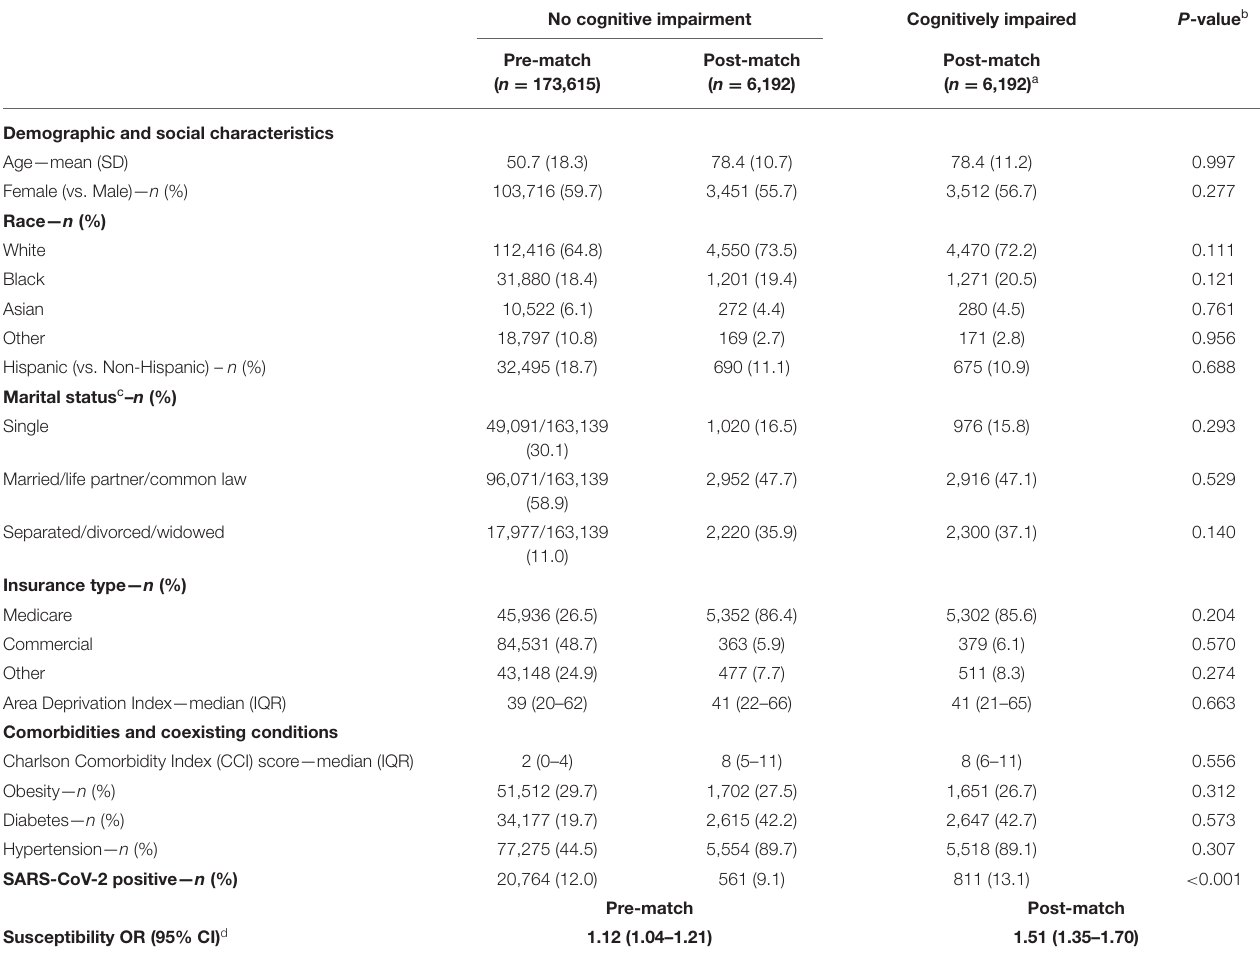
TABLE 1 | Pre- and post-propensity score matched characteristics of adults tested for SARS-CoV-2 at Houston Methodist through December 11th, 2020, by cognitive impairment